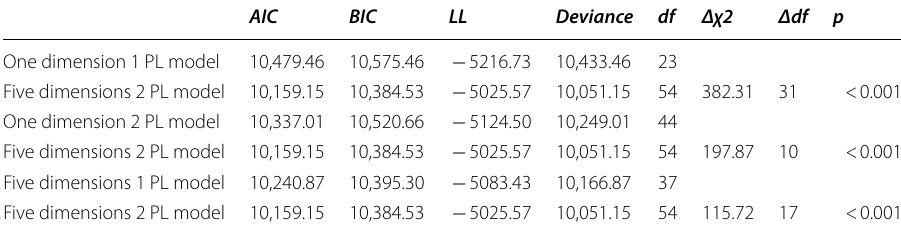
AIC Akaike information criterion, BIC Bayesian information criterion, LL log-likelihood, 1 PL Rasch Model, 2 PL Birnbaum